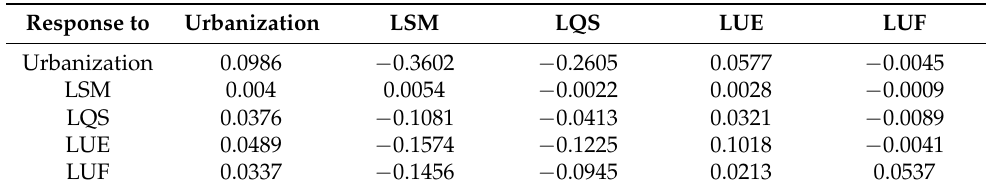
Table 9. Cumulative impulse response values of Model